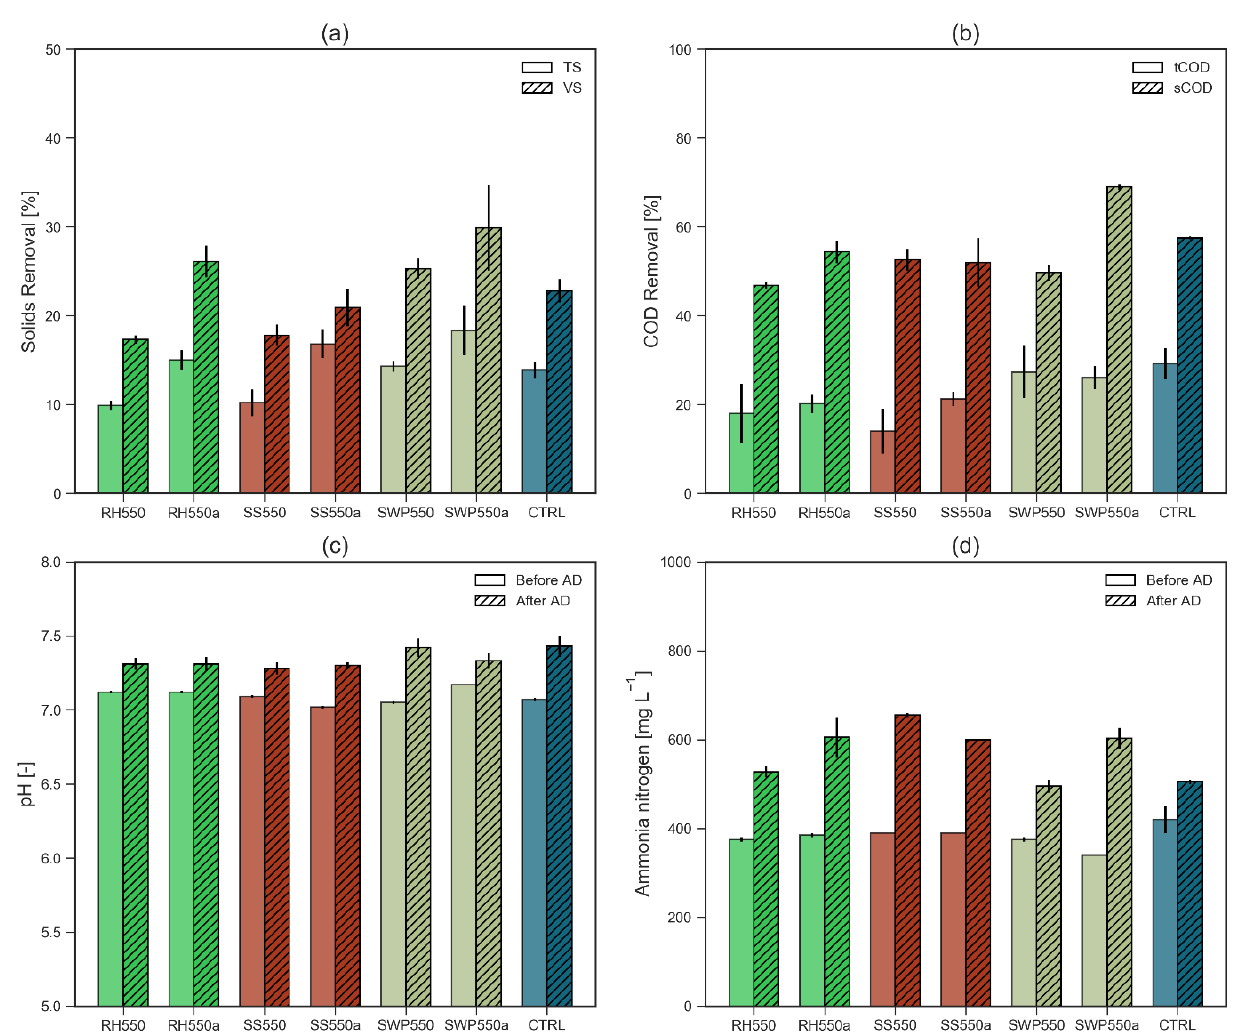
Figure 2. Removal of organic matter during anaerobic digestion (AD) and sludge properties before and after AD: ( a ) Removals of total solids (TS) and volatile solids (VS) during AD; ( b ) Removals of total (tCOD) and soluble COD (sCOD) during AD; ( c ) pH before and after AD; ( d ) Ammonia nitrogen before and after AD.